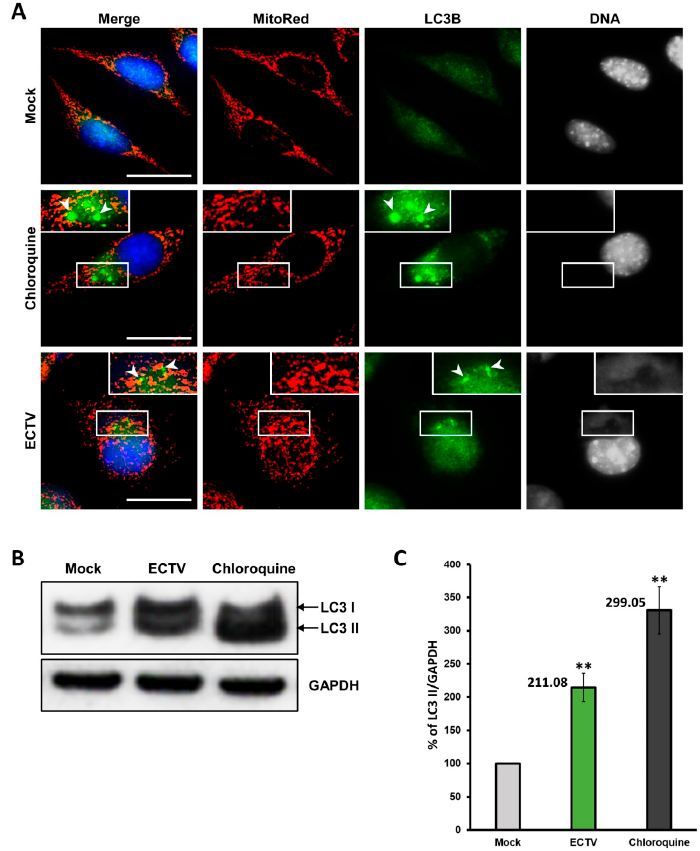
Figure 16. ECTV induces autophagy in later stages of infection in L929 fibroblasts. Uninfected cells pretreated with 30 µM chloroquine for 16 h were used as a positive control. ( A ) The microtubule- associated light chain 3B (LC3B) staining; ( B ) representative Western blots of LC3B at 18 hpi; ( C ) densitometry analysis of LC3 II at 18 hpi. The level of protein was normalized to GAPDH. Data from three independent experiments are presented as mean ± SD. Student’s t -test; ** p ≤ 0.01. Scale bar: 20 µm ( A ).